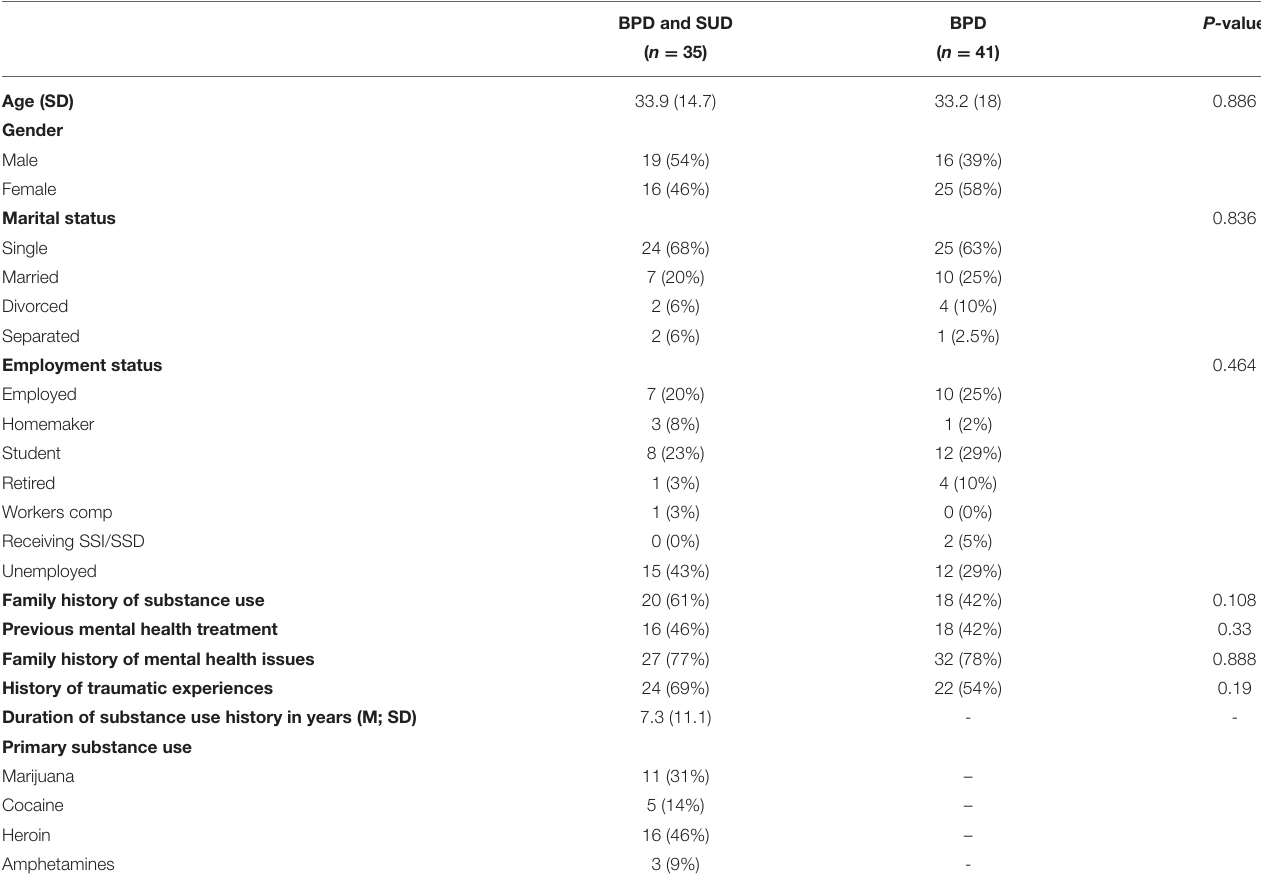
TABLE 1 | Sociodemographic and clinical history of